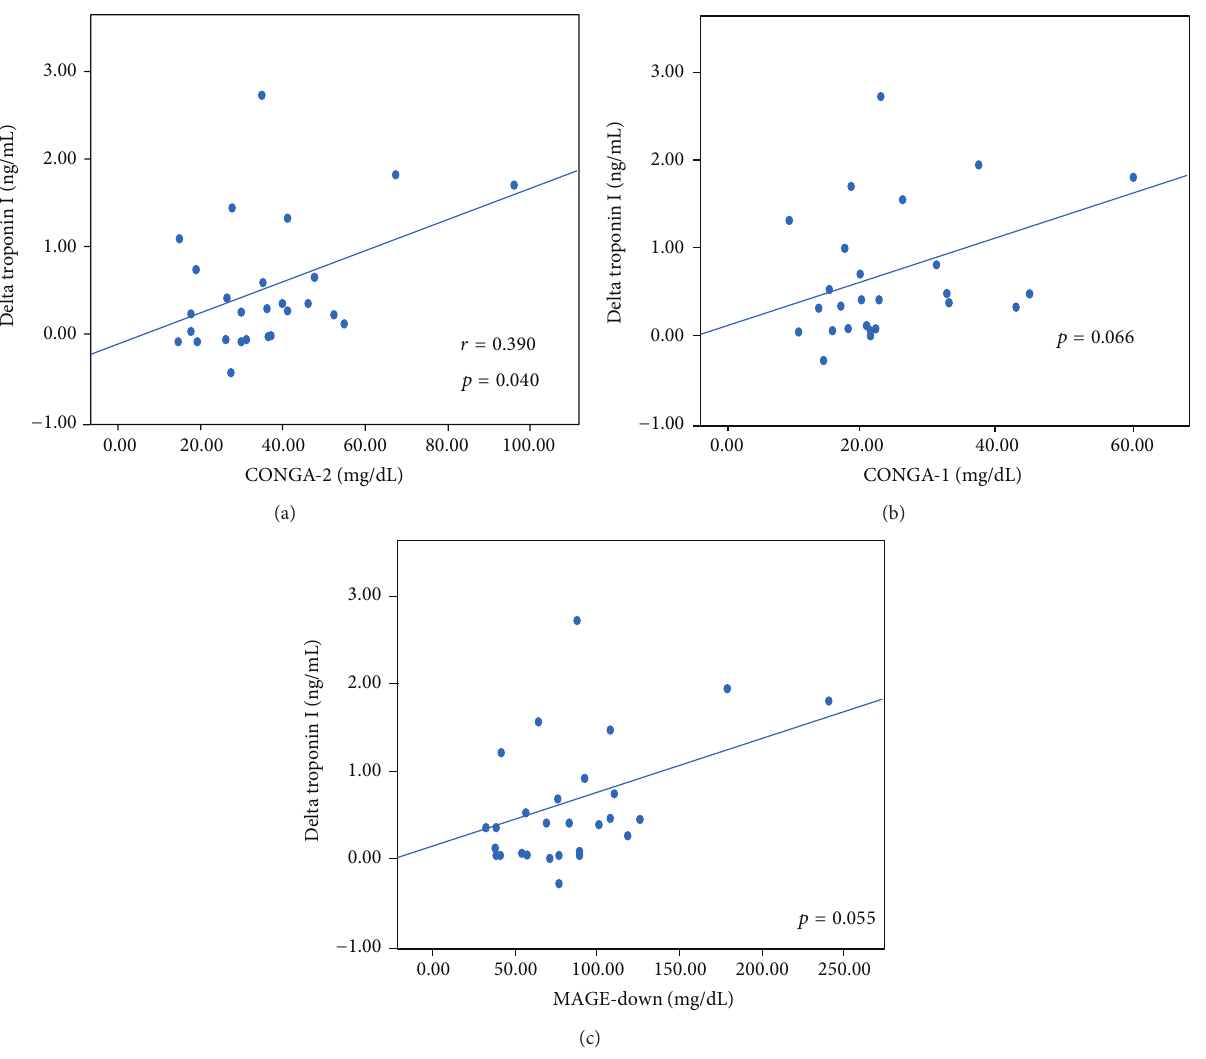
Figure 4: Correlation between periprocedural glycemic variability (expressed as CONGA-2, CONGA-1, and MAGE-down) and postproce- dural troponin I increase. CONGA-1: continuous overall net glycemic action at 1 hour; CONGA-2: continuous overall net glycemic action at 2 hours; MAGE-down: mean amplitude glycemic peak-to-nadir